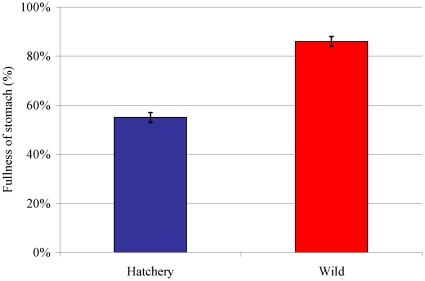
The mean stomach fullness of wild and hatchery coho salmon smolts in the Campbell River estuary and near-shore area from 2007 to 2009, with standard error.